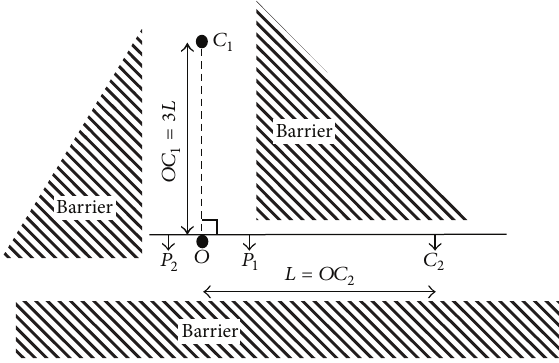
Figure 4: Diagrammatic representation of electrode spread in congested area with limited access illustrating Hummel array.